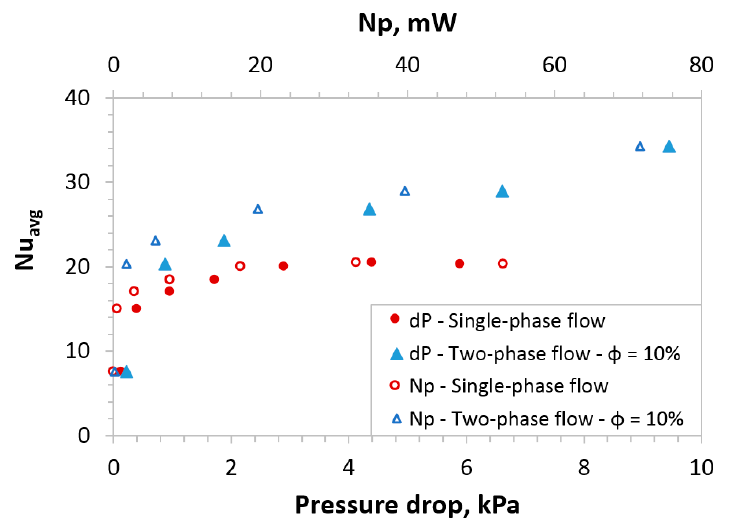
Figure 13. Dependence of the average Nusselt number on the pressure drop for single phase and two-phase flow.